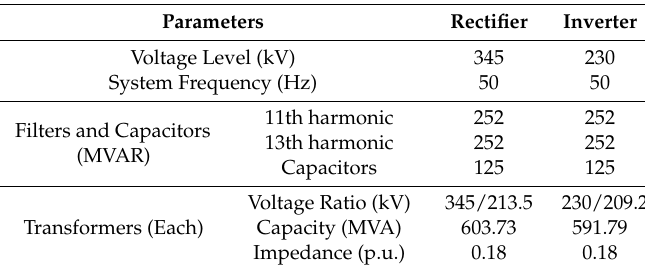
Table A2. AC side parameters of dual-infeed HVDC